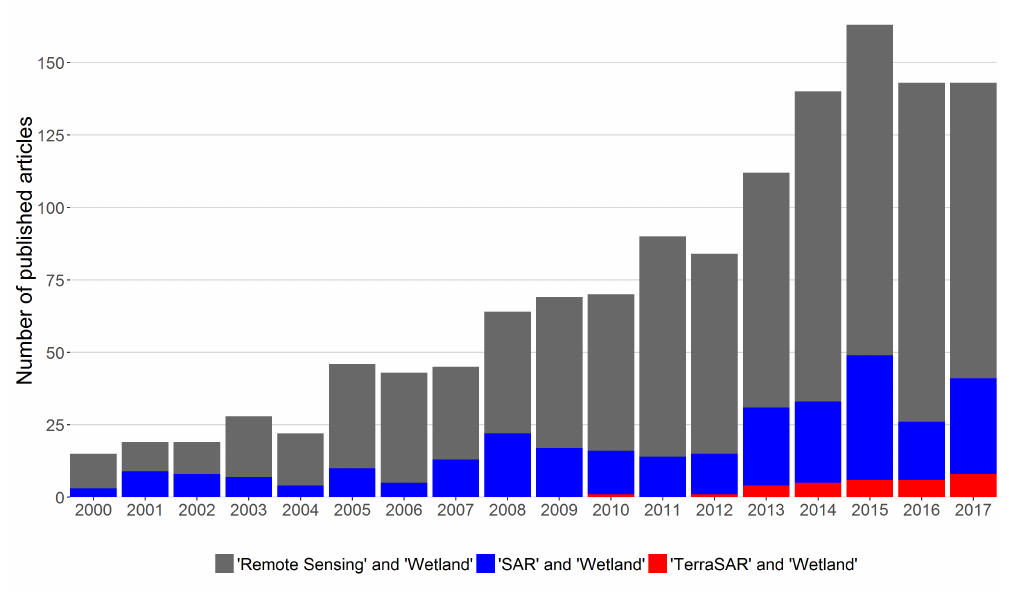
Figure 1. Number of wetland publications using remote sensing (gray), synthetic aperture radar (SAR, blue), and TerraSAR-X (red) data from 2000 to